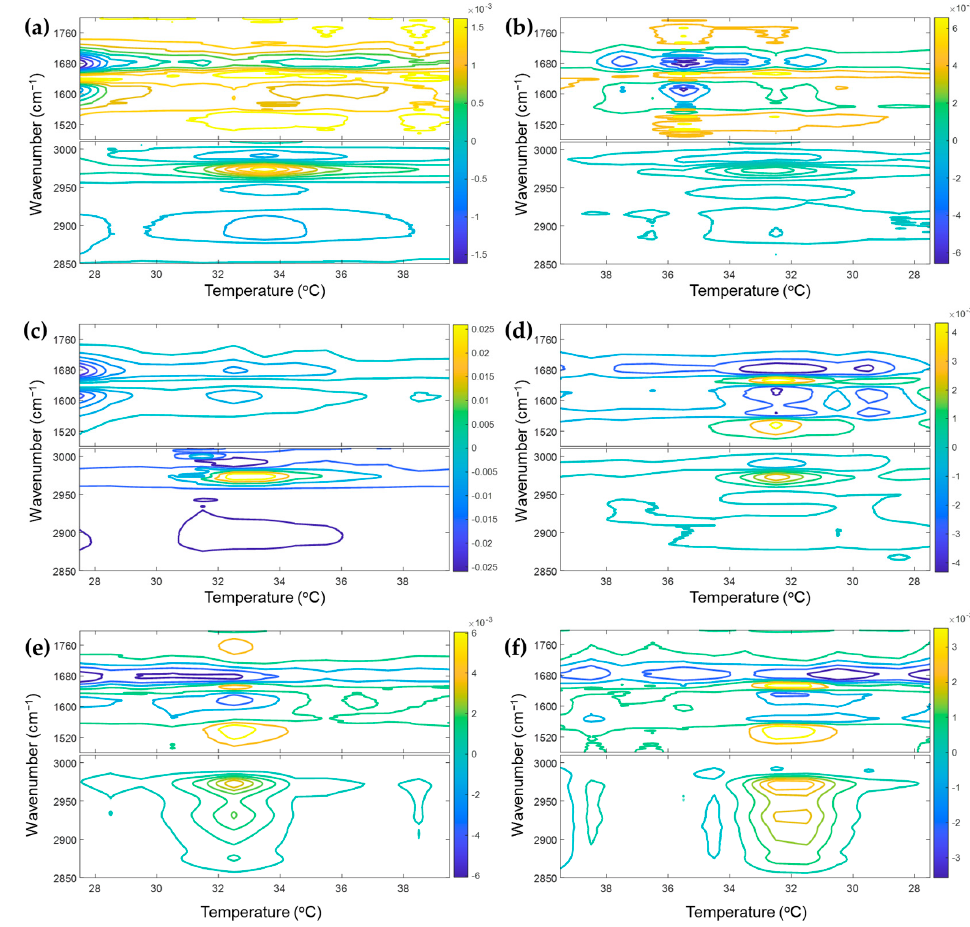
Figure 2. 2D gradient maps obtained from temperature-dependent IR spectra of P(NiPAAm- co -AAc) hydrogel with different pHs ( a , b : 4, c , d : 3, e , f : 2). Heating processes are ( a , c , e ), and the cooling process are ( b , d , f ).